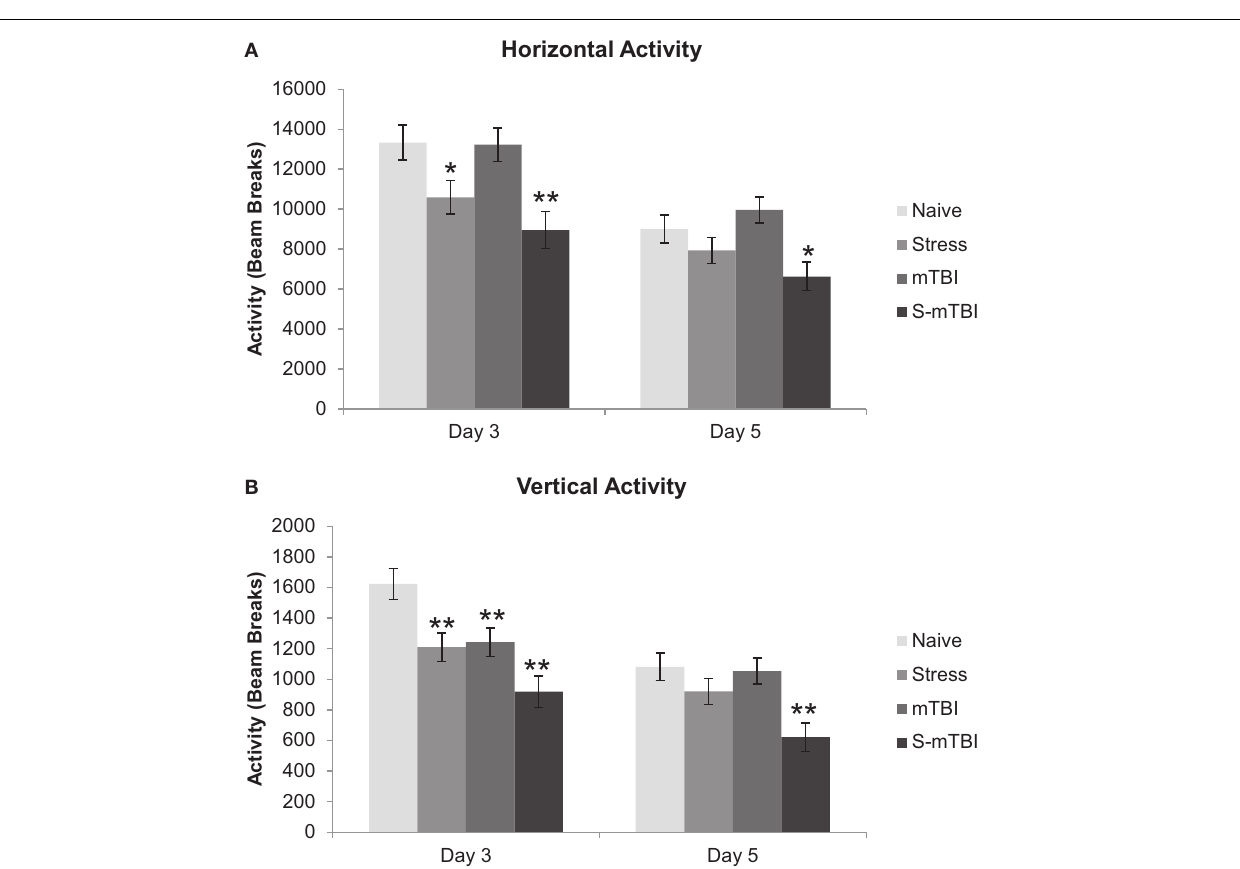
the experiment. (B) Vertical activity (measure of depression-related behavior) of the animals throughout the experiment.Vertical activity measurement post injury was covaried for baseline measurements due to differences at baseline between groups. * p < 0.05, ** p < 0.01 vs. Naïves,